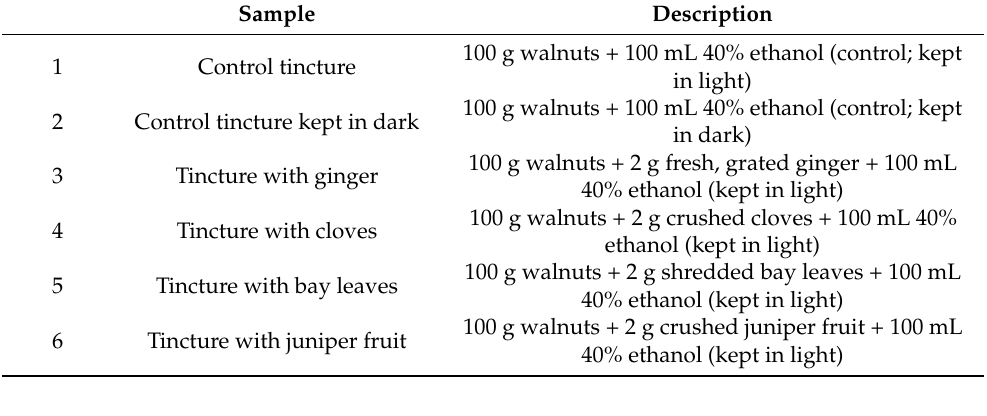
Table 1. The composition of the prepared tinctures.